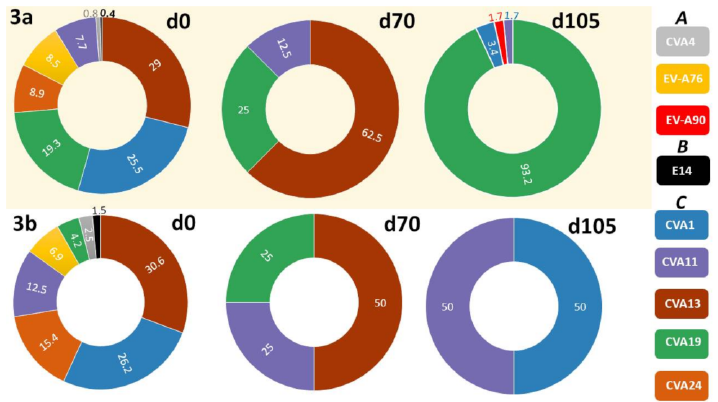
Figure 3. Relative abundance of enterovirus variants recovered on three (3) of the sampling days (0, 70 and 105) using assays 3a and 3b (LRISW). Numbers in chart are percentages reflecting the cumulative number of variants across all sites where the different EV types were detected on any specific sampling day. Note that the image above only displays variants recovered using assays 3a and 3b (LRISW). Particularly, the CVA24 and CVA13 recovered on days 28 and 105, respectively, using assay 2 (SSW) are not shown here. Note that d0, d70 and d105 mean EV types detected in samples collected on days 0, 70 and 105,